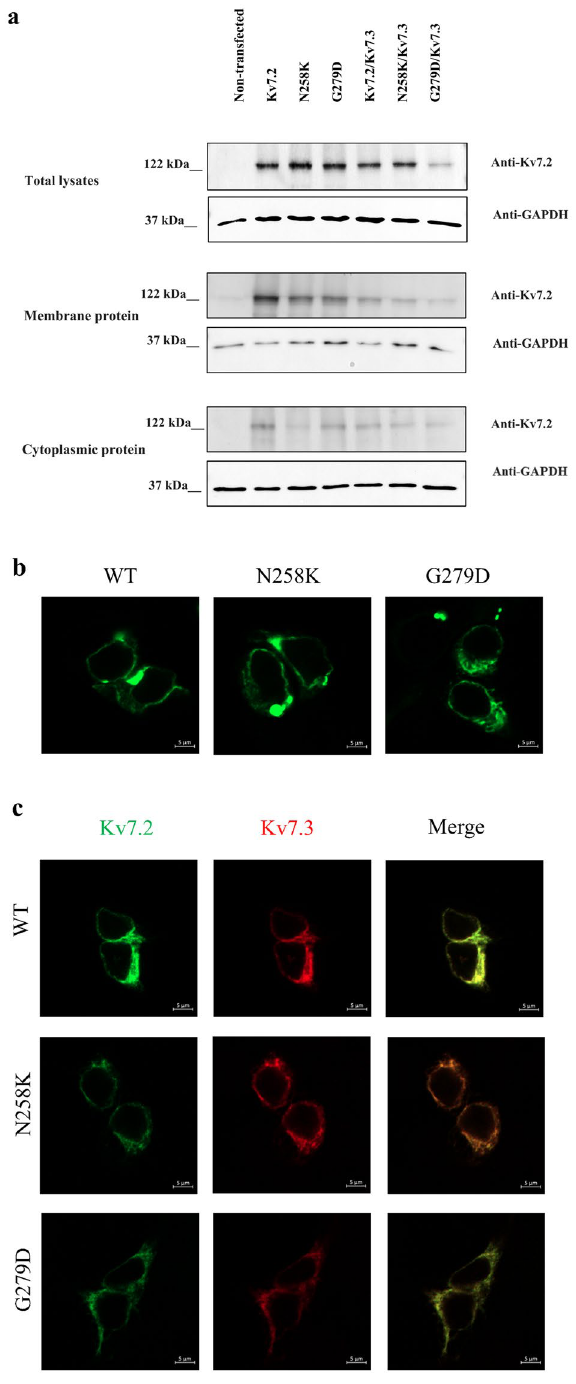
Figure 2. p.(N258K) and p.(G279D) Kv 7.2 diminishes Kv 7.2 surface membrane expression. ( a ) Western blots analysis of Kv 7.2 protein expressions in membrane, cytoplasmic and total cell lysate of cells expressing Kv7.2WT, p.(N258K) and p.(G279D), WT Kv7.2/Kv7.3, or p.(N258K) or p.(G279D) co-expressed with Kv7.3. Non- transfected HEK293 cells was used as a negative control and GAPDH as a loading control. ( b ) Representative confocal microscopy images of HEK 293 cells expressing either Kv7.2WT, p.(N258K) or p.G27D. Kv7.2WT (left panel), p.(N258K) (middle panel) and G279D (right panel). Scale bar: 5 µm. ( c ) Representative confocal microscopy images of cells expressing Kv7.2WT, p.(N258K) and p.(G279D), WT Kv7.2/Kv7.3, or p.(N258K) or p.(G279D) co-expressed with Kv7.3. Scale bar: 5